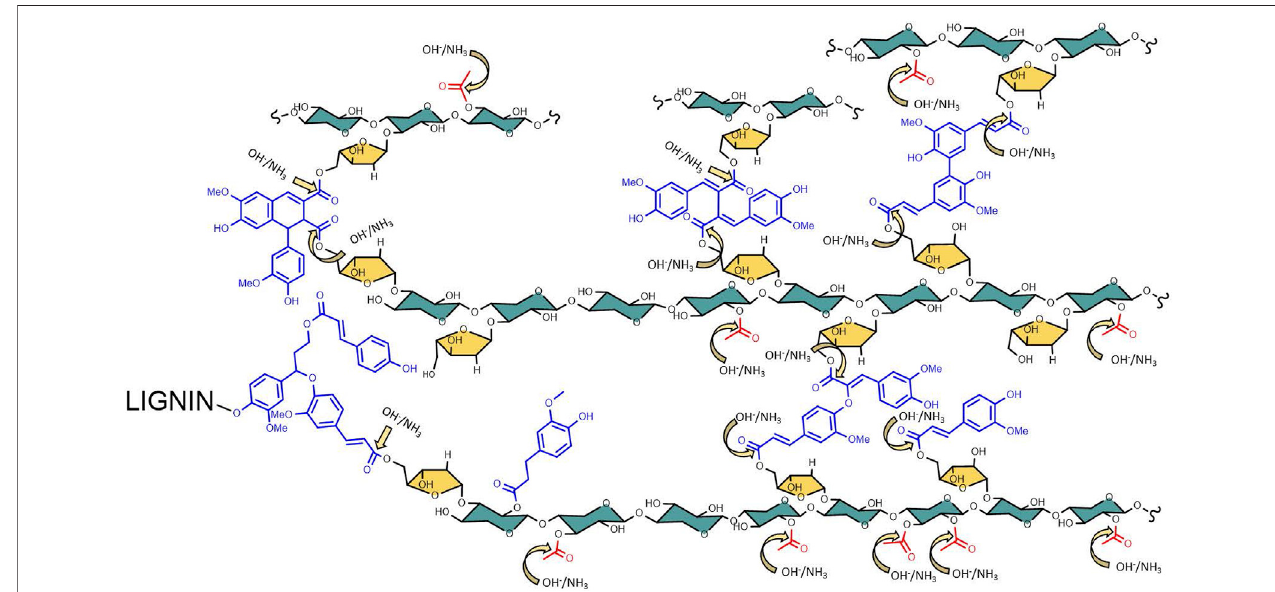
FIGURE2| Arabinoxylanligninlinkages inlignocellulosic biomass. During theAFEXprocess, thetargetedester linkagessites are pronetoattach to hydroxide and ammonia, producing the corresponding acids or carboxamide functional groups.